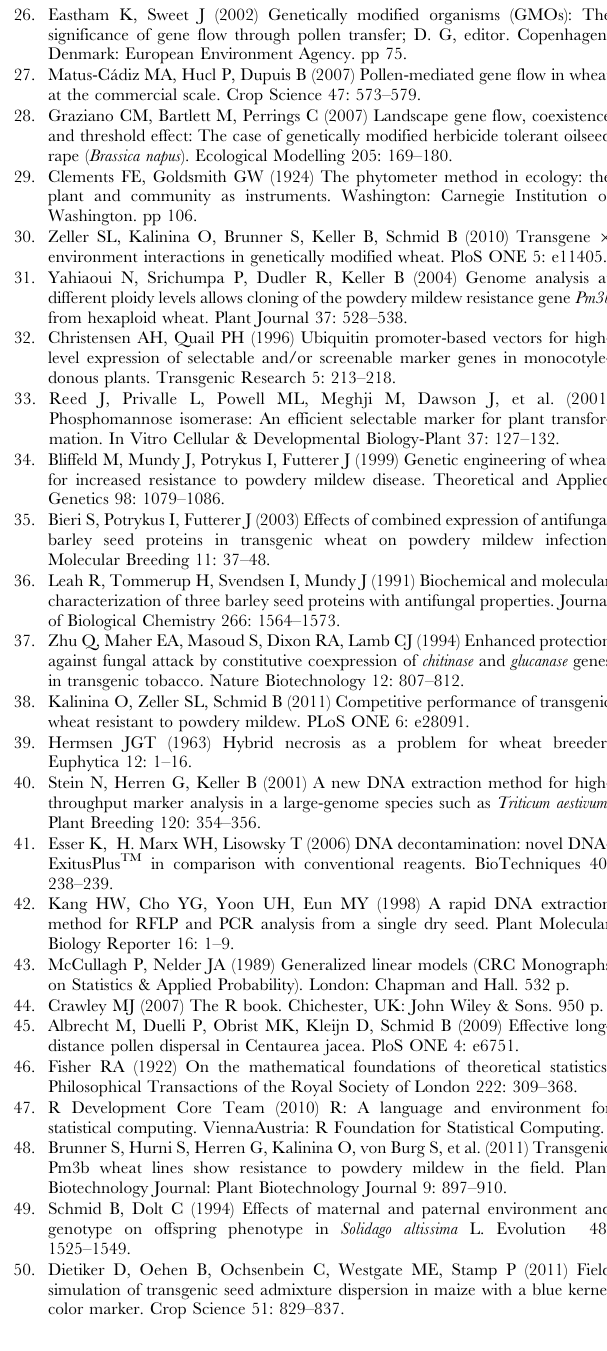
Table S1 Factors influencing the rate of cross-pollina- tion of GM and non-GM wheat in experiment 1. (PDF) Table S2 Factors influencing cross-pollination rates in experiment 2.